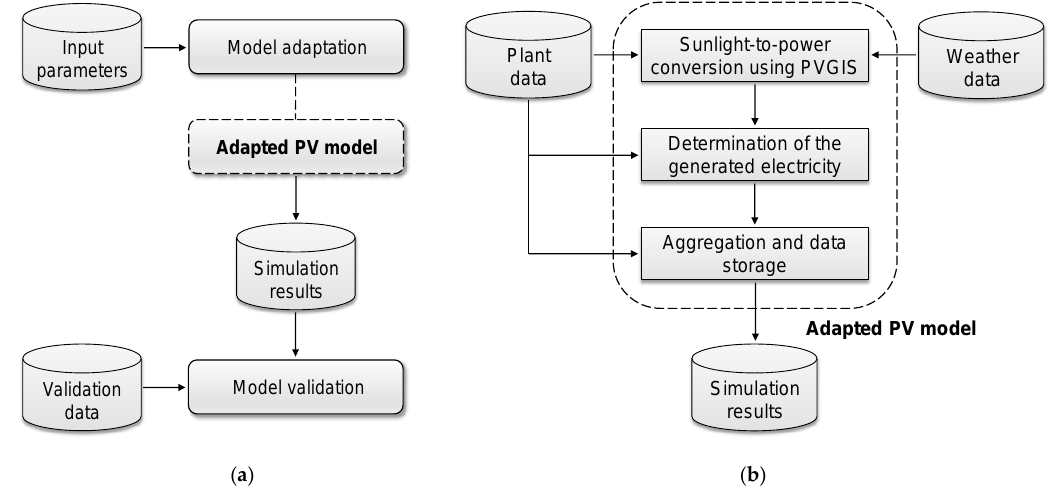
Figure 2. ( a ) Development process and ( b ) structure of the PV model depicted as flowcharts.